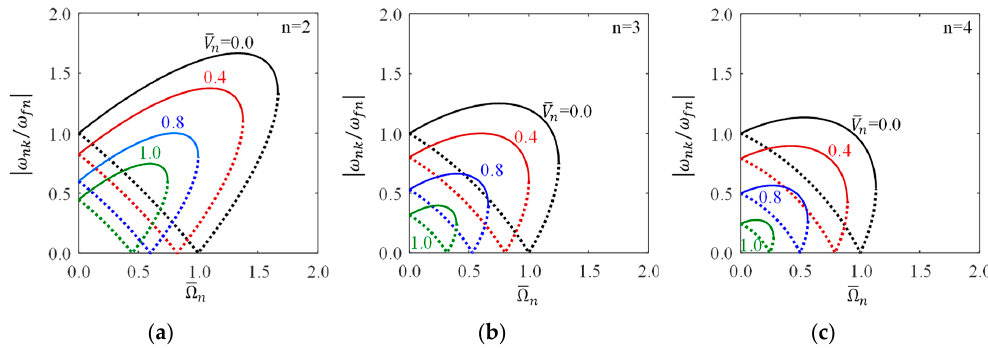
Figure 3. The bifurcation of natural frequencies due to rotation effect under different voltage, wherein the dashed curves are for (cid:2033) (cid:3041)(cid:2869) and solid curves for (cid:2033) (cid:3041)(cid:2870) , Ω(cid:3365) (cid:3041) = Ω (cid:2033) (cid:3033)(cid:3041) ⁄ , and (cid:1848)(cid:3364) (cid:3041) = (cid:3493)(cid:2013)(cid:1848) (cid:2870) (cid:2025)ℎ(cid:1859) (cid:2871) ⁄ (cid:2033) (cid:3033)(cid:3041) (cid:3415) . ( a ) n = 2; ( b ) n = 3; ( c ) n = 4.